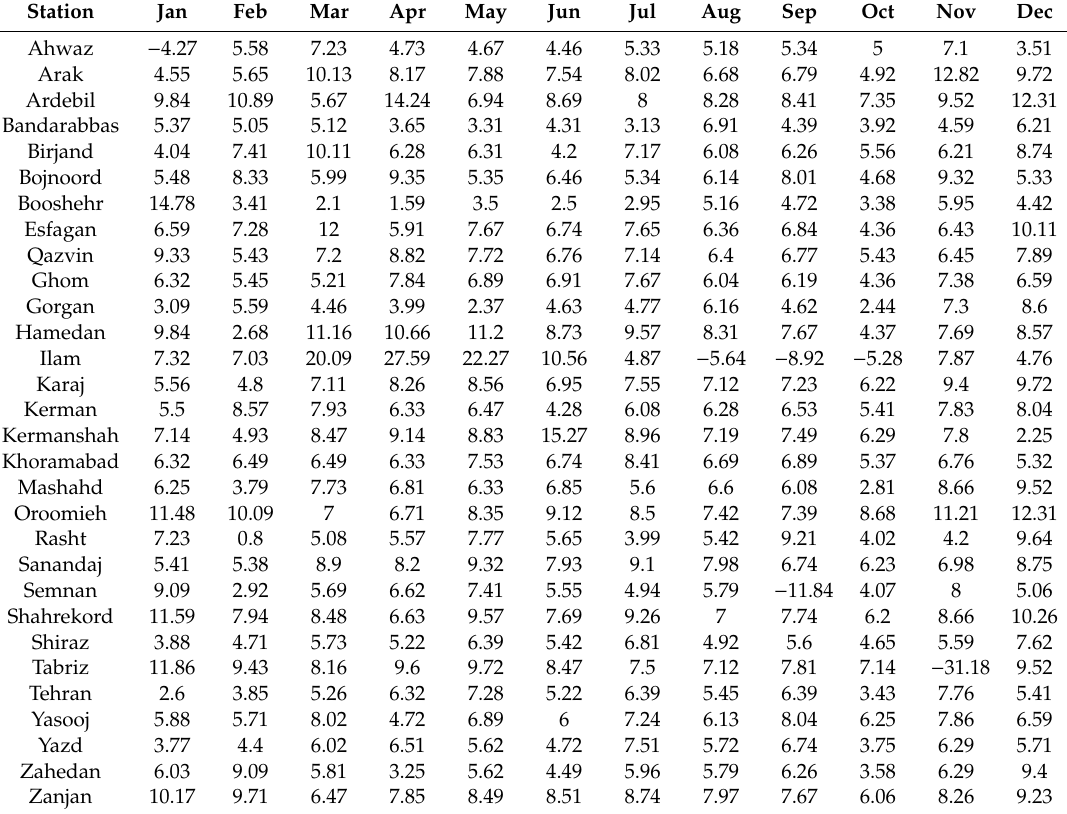
Table 9. Change percentages of the ET 0 predicted for the period from 2080 to 2113 under the B1 scenario.